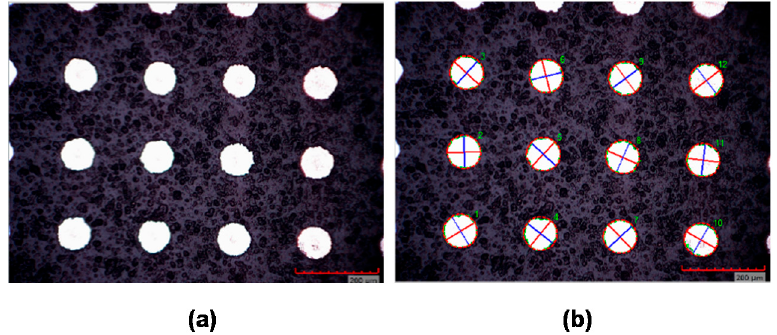
Figure 3. Example of the analysis by a Matlab function: ( a ) high contrast image of dimples from an optical microscope, ( b ) analyzed microscope image with shown fitted ellipses and their axes (red—major axis, blue—minor axis).